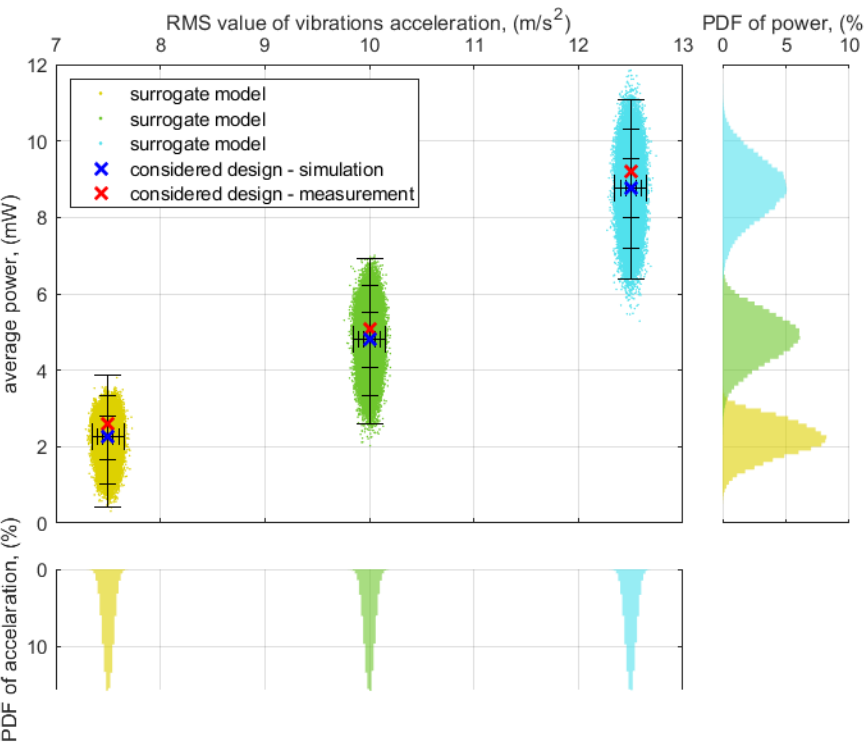
Figure 13. Average power for 10 5 design points with probability density functions (PDF) and errorbars denoting confidence levels taking into account the error of the surrogate model.